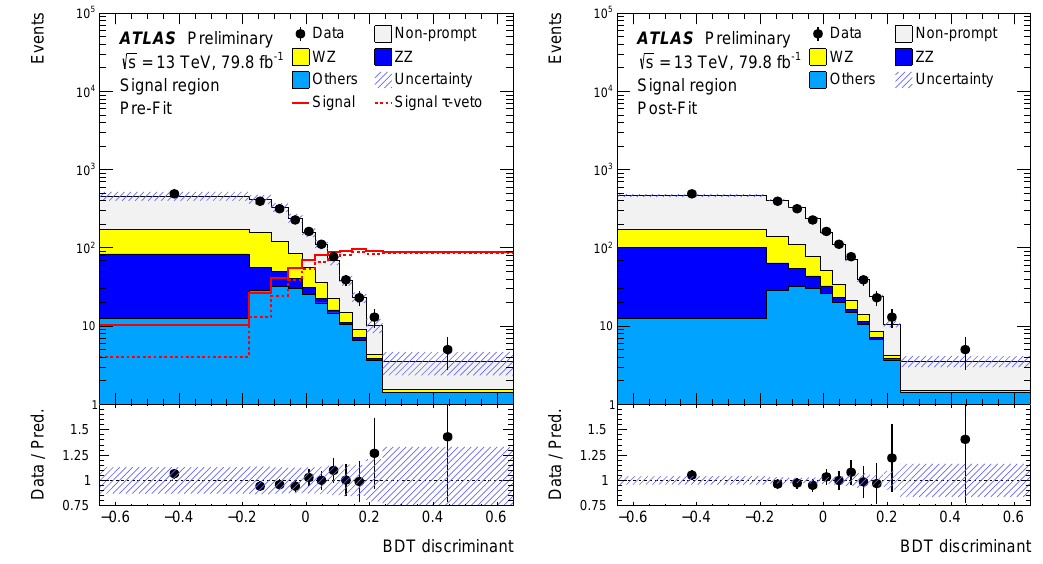
Figure 9: The pre-fit (left) and post-fit (right) distributions of the BDT classifier score [ 24 ] . On the left plot, the signal is represented by the red histogram plotted